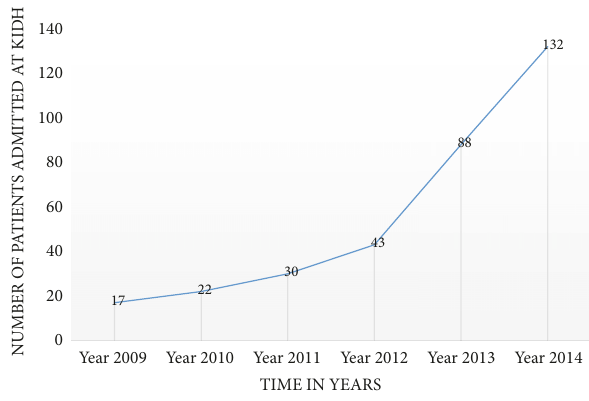
Figure1:Trendshowingincreaseinpatientsoveryears(2009-2014).